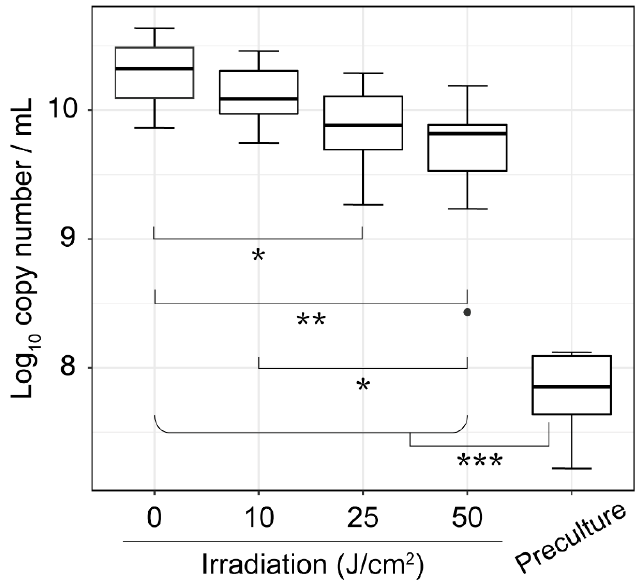
Figure 1. Changes in total bacterial density with increasing violet LED irradiation dose. The total number of bacterial DNA was estimated using universal bacterial 16S rRNA primers for PCR quantification. Statistical significance is indicated by horizontal lines (* p < 0.05, ** p < 0.001, *** p < 0.0001, Wilcoxon rank-sum test).